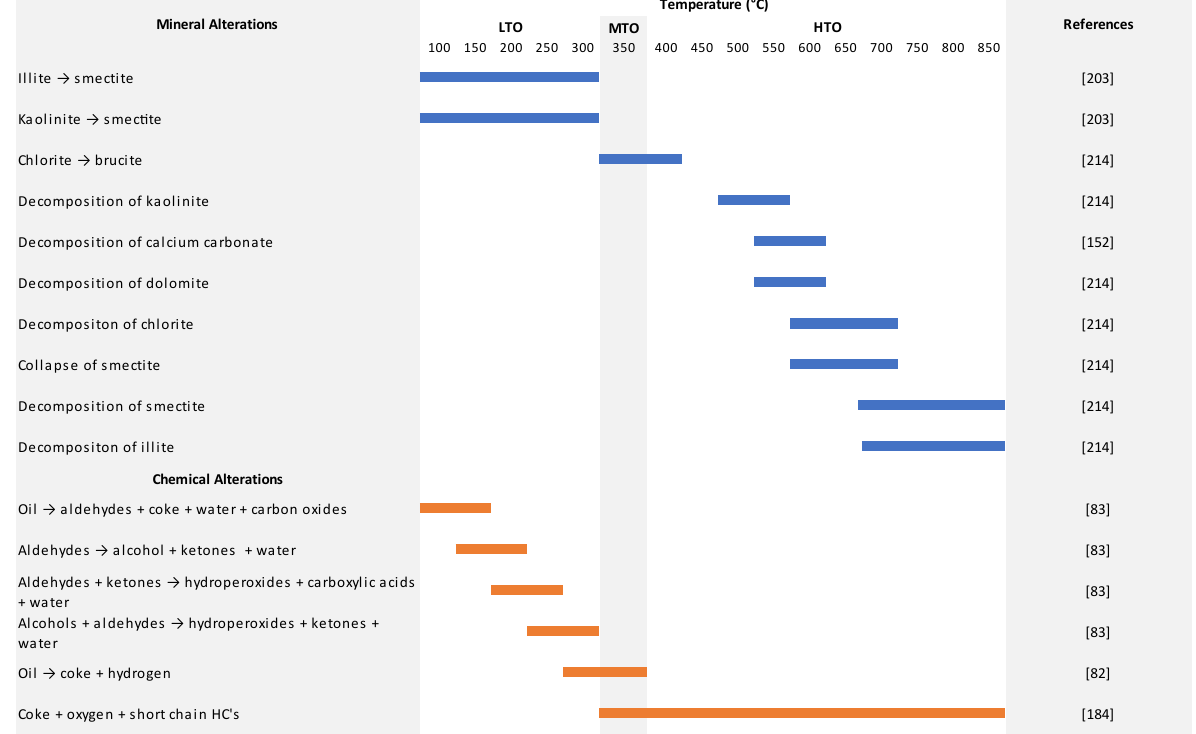
Figure 11. Representation of mineral and chemical (oil-related) alterations and in which oxidation zones they occur, the majority of chemical (oil) alterations occur during LTO (low temperature oxidation) whereas mineral alterations tend to happen in the HTO (high temperature oxidation) region. MTO represents medium temperature